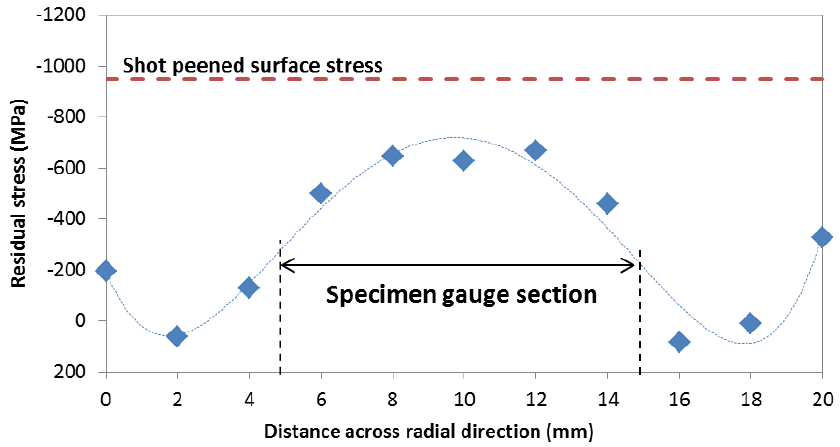
Figure 13. Axial residual stress data measured across the radial plane of a swaged bar.